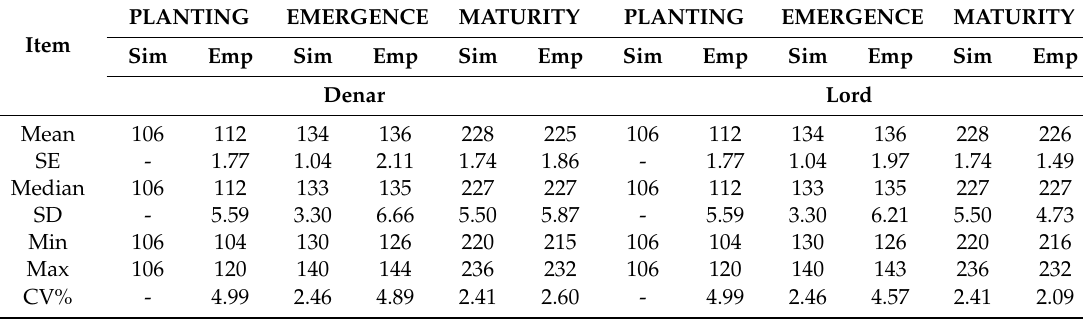
Table 6. Comparison of simulated (Sim) and empirical (Emp) lengths of stages of plant development (days): tuber planting, emergency and